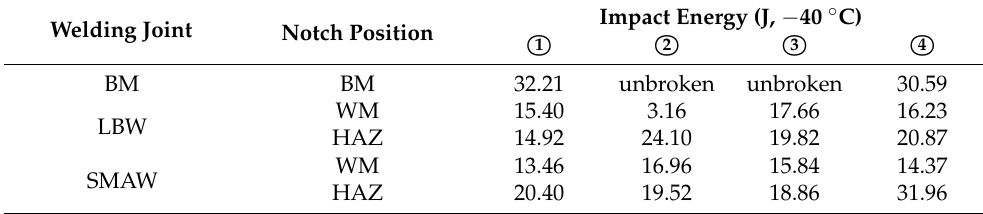
Table 4. Results of tensile